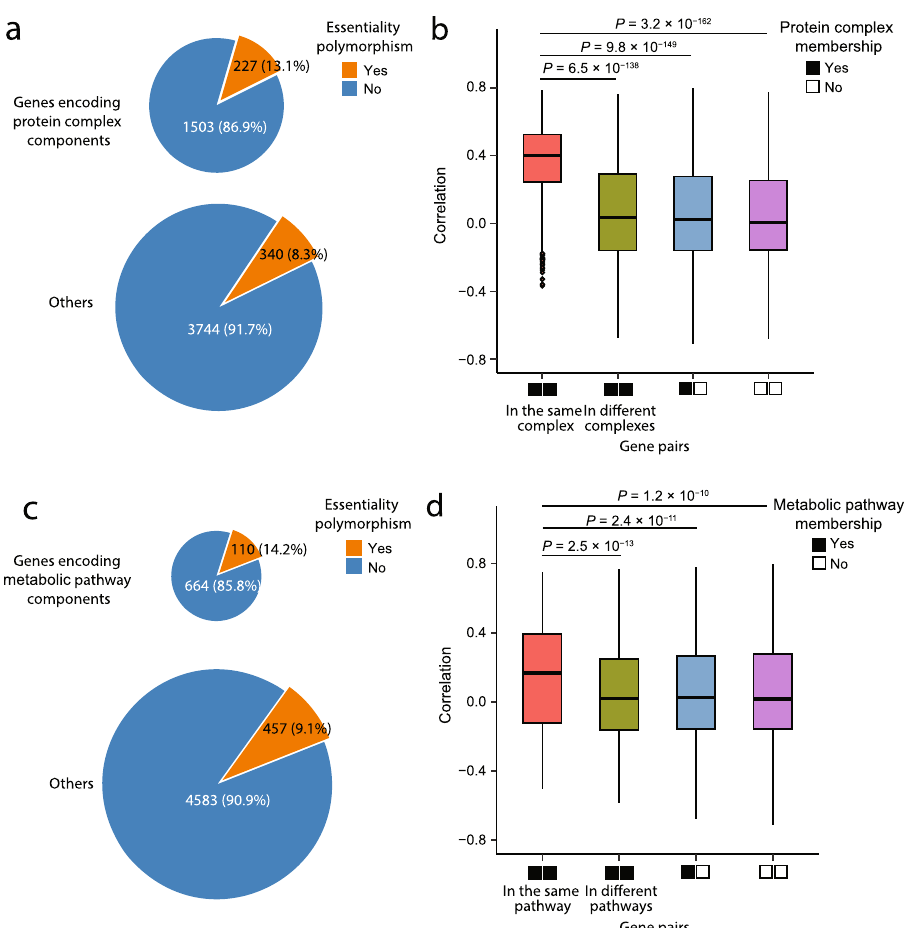
Fig. 5 Coordinated essentiality changes of genes encoding members of the same protein complex or metabolic pathway. a Genes encoding protein complex components are more likely than other genes to exhibit essentiality polymorphism ( P = 1.74 × 10 − 8 , one-tailed chi-squared test). Pie size is proportional to gene number. b Correlations presented in Fig. 4a are greater for pairs of genes encoding components of the same protein complex ( n = 643 gene pairs) than those encoding components of different complexes ( n = 24,782), those including only one gene encoding a complex component (indicated by one black square and one white square on the x -axis; n = 77,066), and those not encoding complex components (indicated by two white squares on the x -axis; n = 57,970). c Genes encoding metabolic pathway components are more likely than other genes to exhibit essentiality polymorphism ( P = 7.07 × 10 − 6 , one-tailed chi-squared test). Pie size is proportional to gene number. d Correlations presented in Fig. 4a are greater for pairs of genes encoding components of the same metabolic pathway ( n = 434) than those encoding components of different pathways ( n = 5561), those including only one gene encoding a pathway component ( n = 50,270), and those not encoding pathway components ( n = 104,196). In the box plots of panels b and d, the lower and upper edges of a box represent the fi rst ( qu 1 ) and third ( qu 3 ) quartiles, respectively, the horizontal line inside the box indicates the median ( md ), the whiskers extend to the most extreme values inside inner fences, md ± 1.5( qu 3 − qu 1 ), and the dots represent values outside the inner fences (outliers). P -values are from two-tailed Wilcoxon rank-sum tests. Source data are provided as a Source Data fi